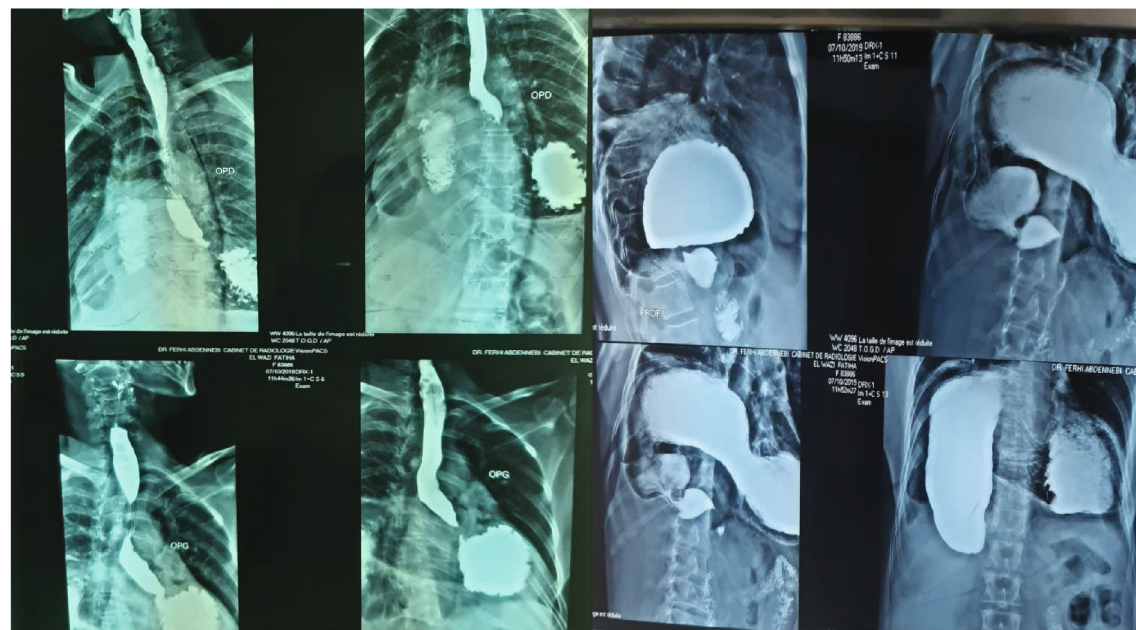
Figure 2: An upper gastrointestinal contrast showing a gastric plication with anteropyloroduodenal malrotation.